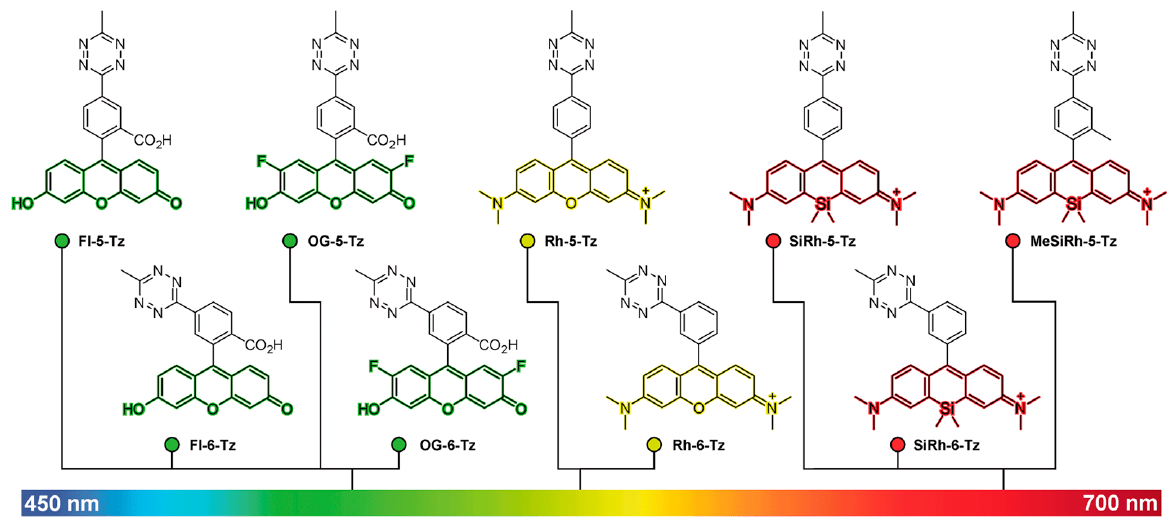
Figure 2. Tetrazine-functionalized fluorophore via a Dexter-type, electron-exchange strategy. This figure represents the chemical structures and emission wavelengths of the green to far-red emissions of fluorogenic tetrazine-functionalized xanthene derivatives. Reproduced from [28] with permission from the Royal Society of Chemistry.